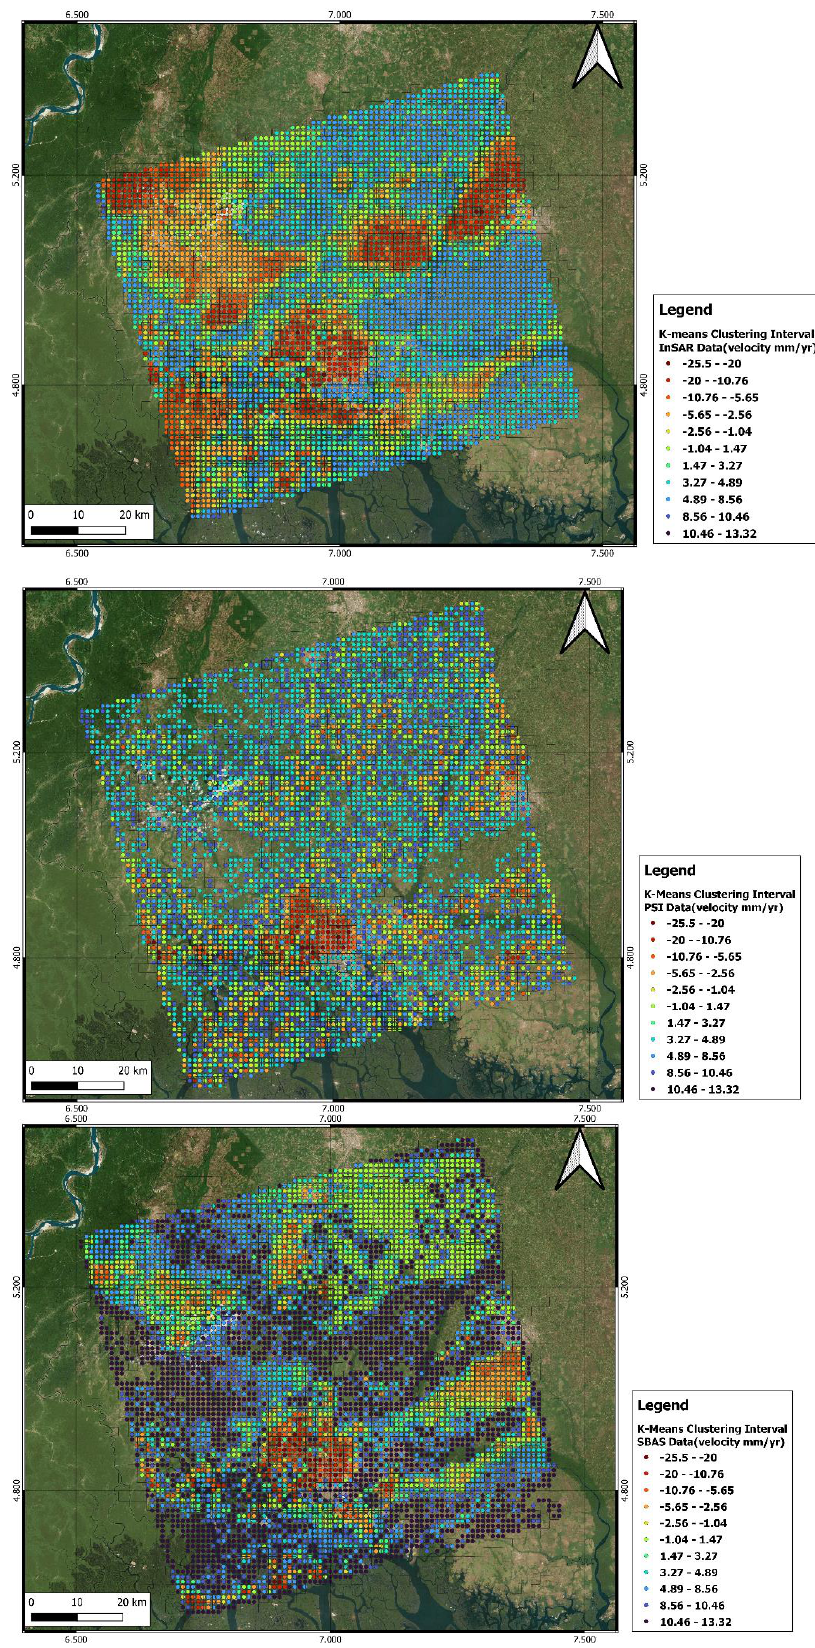
Figure 12. Obtained mean displacement rate maps from different interferometric techniques, including ( up ) InSAR, ( mid ) PSI, and ( down ) SBAS, by applying the K-means clustering algorithm.